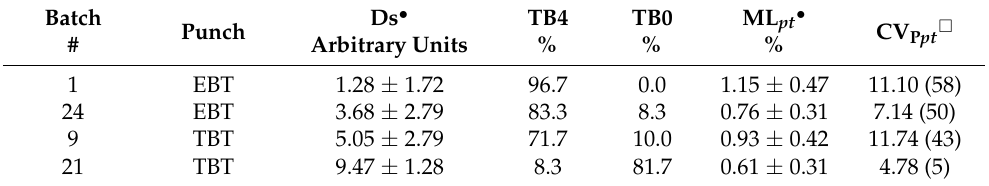
Table 6. Panel test results. CV P pt , coefficient of variation of portion mass; DS, difficulty in tablet subdivision; ML pt , mass loss following splitting into four portions; TB4, percentage of tablets that panelists could break into four portions; TB0, percentage of tablets that panelists could not